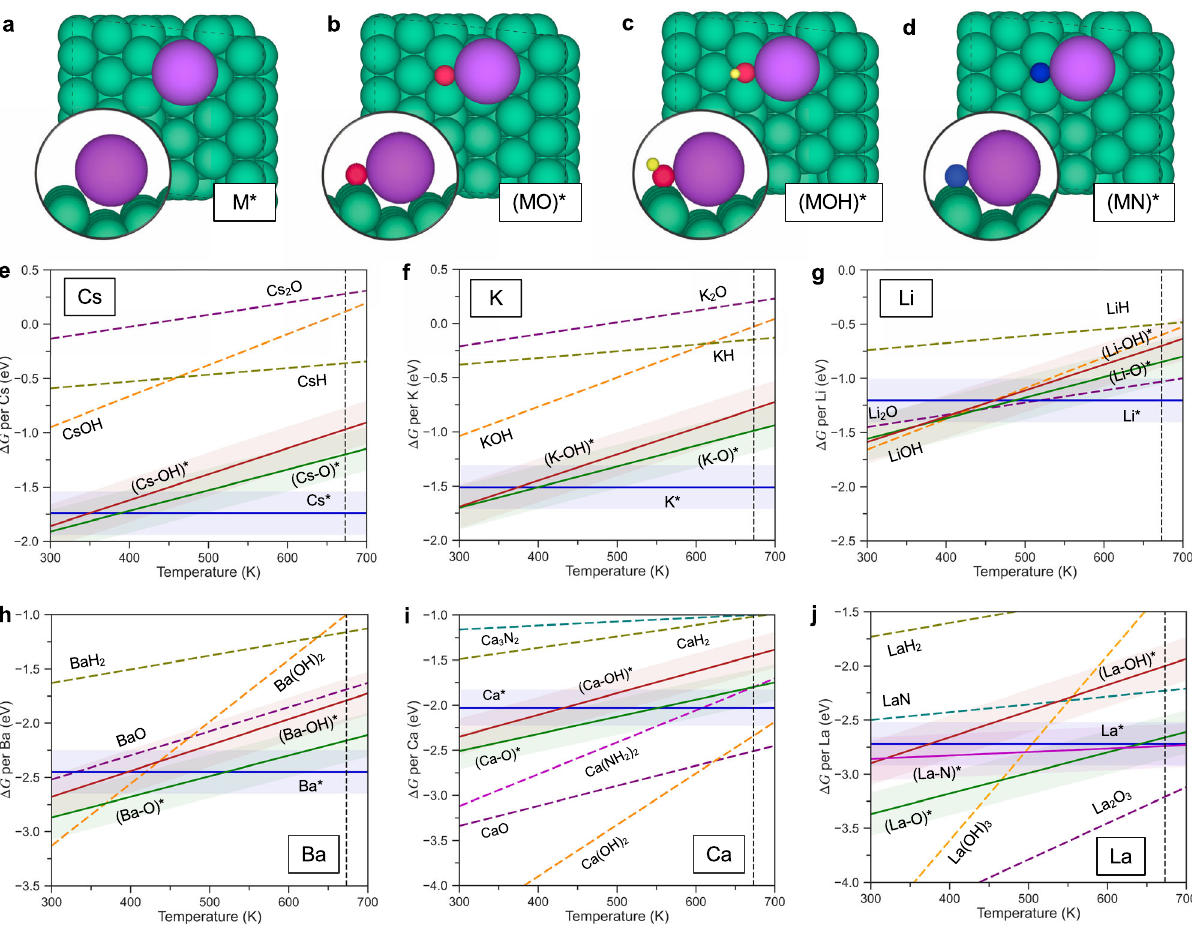
Fig. 2 Surface phase diagrams. a – d Top and side view of adsorption structures of M*/(MO)*/(MOH)*/(MN)* on the Ru(10 (cid:1) 15) surface. M means metallic promoter atom. Green, purple, red, yellow, and blue spheres represent Ru, promoter M, oxygen, hydrogen, and nitrogen atoms. e – j Phase diagrams of Cs, K, Li, Ba, Ca and La promoted Ru in equilibrium with their oxides, hydroxides hydrides, nitrides or amides under reaction conditions. Bulk species are shown as dashed lines, while adsorbed species are shown as full lines and identi fi ed by a *. A typical DFT uncertainty of ±0.2 eV is shown shaded for the adsorbed species. The reaction conditions are T = 673 K, H 2 = 7.5 bar, NH 3 = 0.1 bar (N 2 conversion of 2%), P H2O = 10 − 7 bar, chosen to simulate an extremely dry reactant gas. All data used in the fi gure can be found in Supplementary Tables 2 –